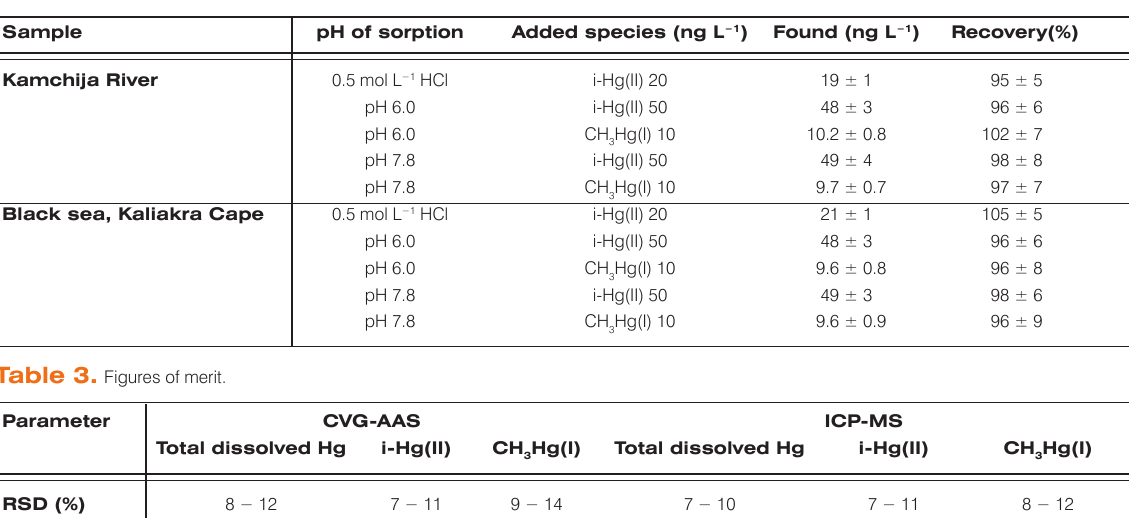
Hg(I); 0.1 mol L −1 3